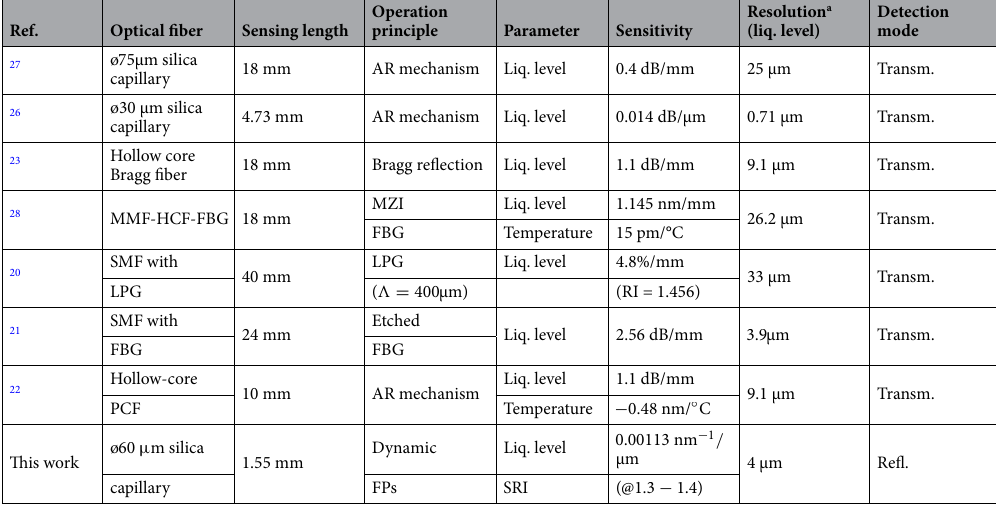
Table 1. Comparative table of the liquid detection sensors in the literature. a A wavelength resolution of 30 pm and intensity resolution of 0.01 dB (typical detector) are considered as reference.